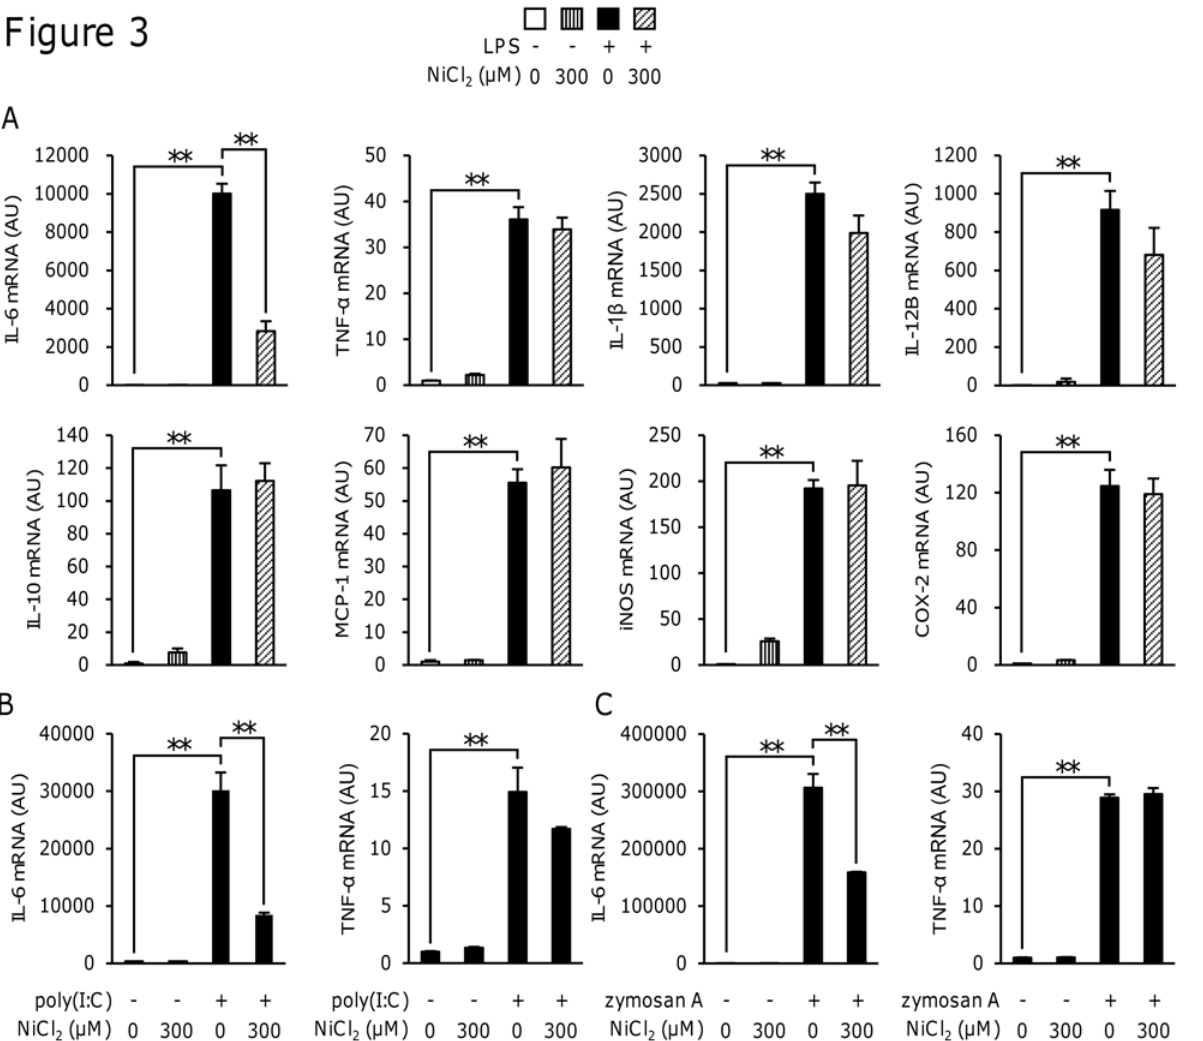
Fig 3. Effects of NiCl2 on the LPS-induced expression of mRNA for inflammatory proteins. RAW264 cells were incubated for 4 h in medium containing LPS (1 μ g/ml) (A), poly(I:C) (50 μ g/ml) (B), or zymosan A (500 μ g/ml) (C) in the presence or absence of NiCl 2 (300 μ M), and mRNAs for various inflammatory proteins were then measured by quantitative real-time PCR. Values are normalized to those of 18 S rRNA and the mean value of the control was set to 1.0. Data represent the mean ± S.E.M. ( n = 4). ** p < 0.01 between the indicated groups. Data are representative of two independent experiments.